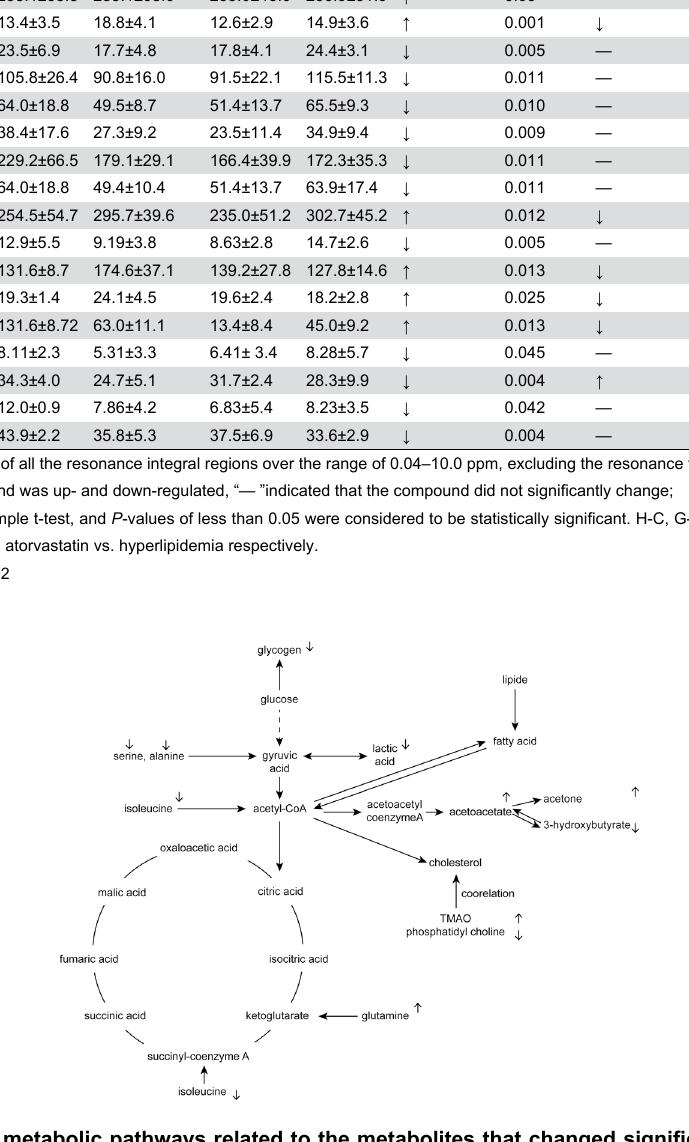
Biological matrices